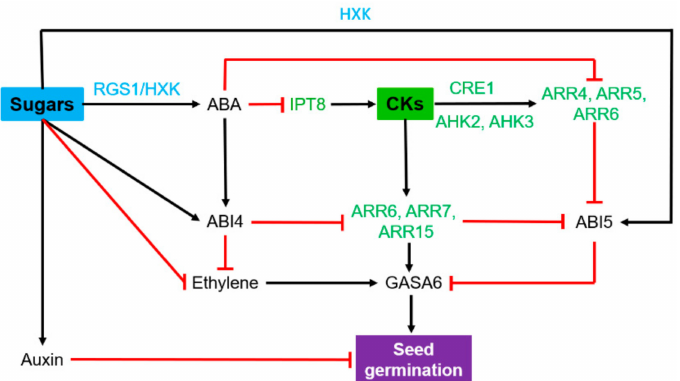
Figure 2. Antagonistic effect of sugars and cytokinins (CKs) on seed germination. Blue stands for players of sugar signaling pathways, and green highlights genes involved in CK synthesis or signaling pathways. Black arrows and red lines indicate stimulatory and inhibitory effects, respectively. ABI, abscisic acid insensitive; AHK, Arabidopsis histidine kinase; ARR, Arabidopsis response regulator; CRE, cytokinin response; GASA, gibberellic acid-stimulated Arabidopsis ; HXK, hexokinase, IPT: isopentenyl transferase; RGS, regulator of G-protein signaling. This model results from a compilation of studies carried out on different model plants (see references and description in the